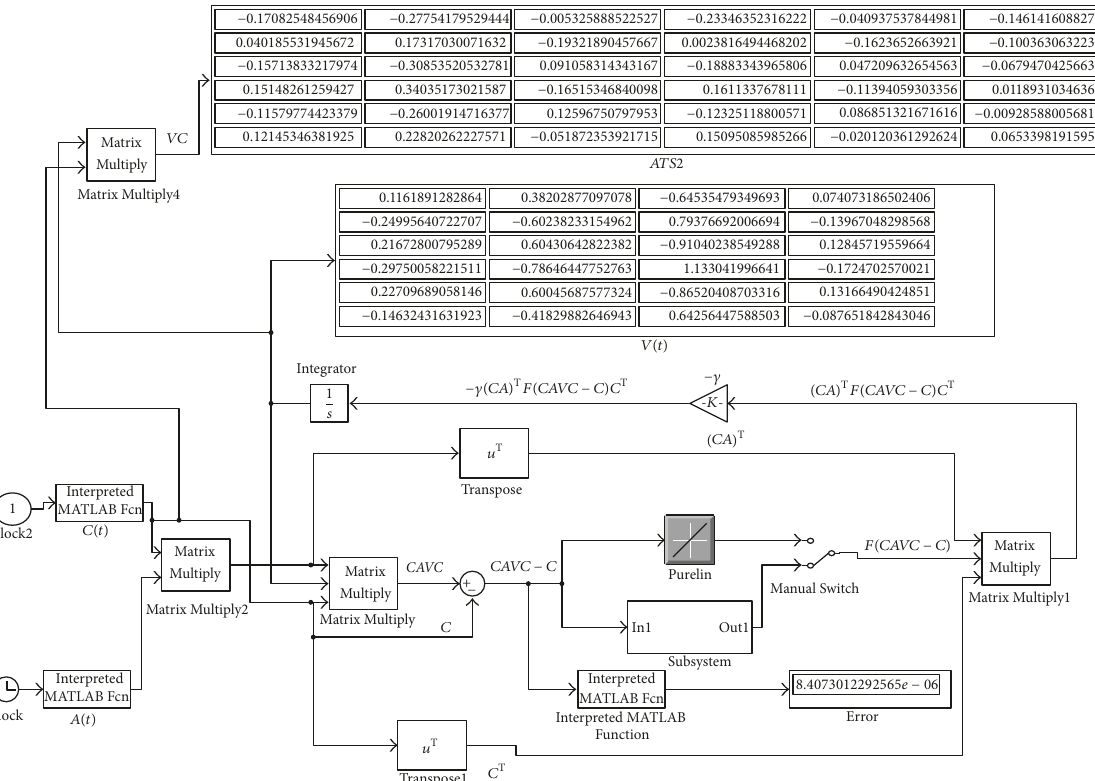
Figure 6: Simulink implementation of the GNN model for computing 𝐶𝐴𝑉𝐶 = 𝐶 , 𝑋 = 𝑉𝐶 ∈ 𝐴{2} ∗, N (퐶)